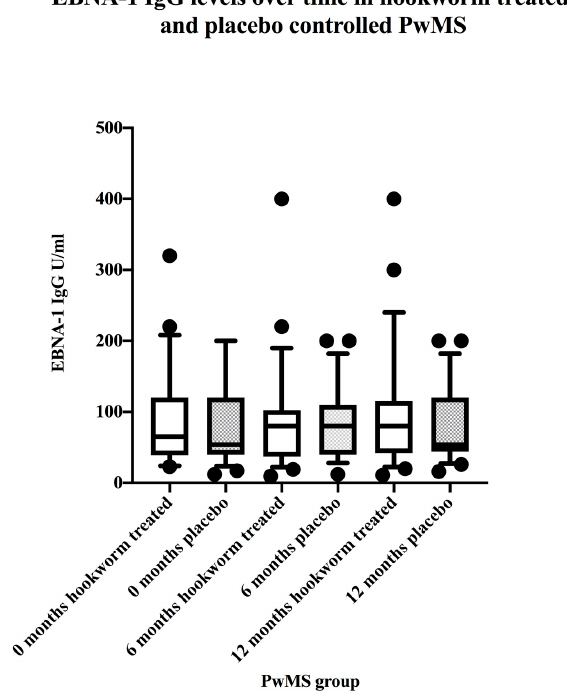
Figure 2. Data represent stability over 12 months of EBNA-1 IgG levels in hookworm-treated and placebo-controlled PwMS. Box and whiskers plots comparing median and 10th and 90th percentile range with outliers of EBNA-1 IgG levels in hookworm-treated (clear) versus placebo-controlled (shaded) PwMS before, during, and after treatments. Table 2. EBV VCA and EBNA-1 geometric mean IgG levels in hookworm-treated ( n = 26) and placebo- controlled ( n = 25) PwMS before, during, and three months after treatment.